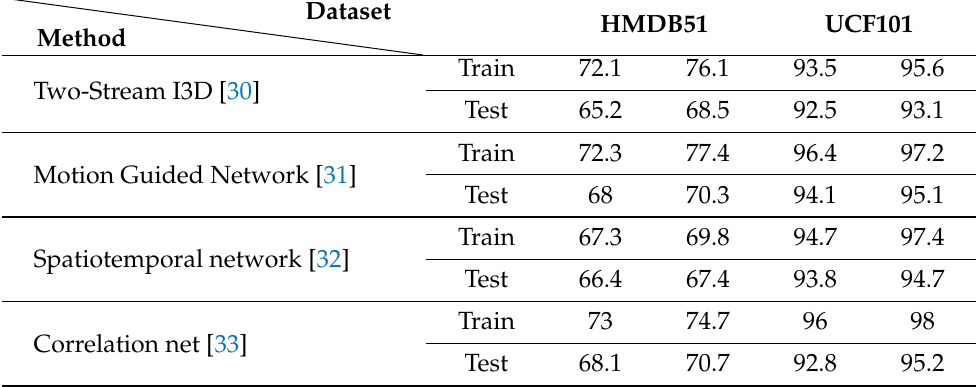
Table 5. Total accuracy obtained by the HAR systems under study with the tuned proposed